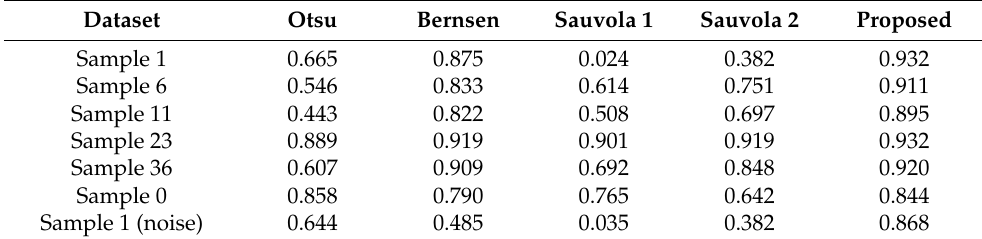
Table 1. F-Measure metric.